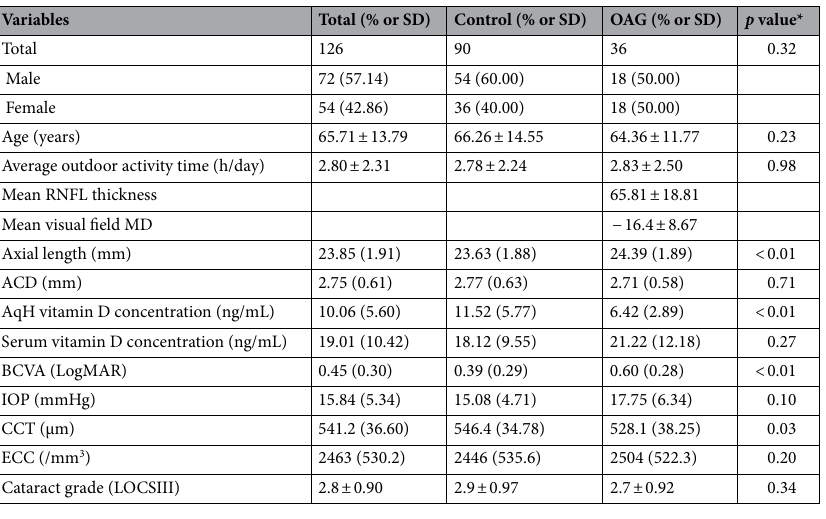
Table 1. Demographic and clinical characteristics of patients with open-angle glaucoma and control subjects. OAG open-angle glaucoma, SD standard deviation, RNFL retinal nerve fiber layer, MD mean deviation, ACD anterior chamber depth, AqH aqueous humor, BCVA best-corrected visual acuity, IOP intraocular pressure, CCT central corneal thickness, ECC endothelial cell count, LOCSIII lens opacities classification system III. *Comparisons between patients with OAG and control subjects based on t